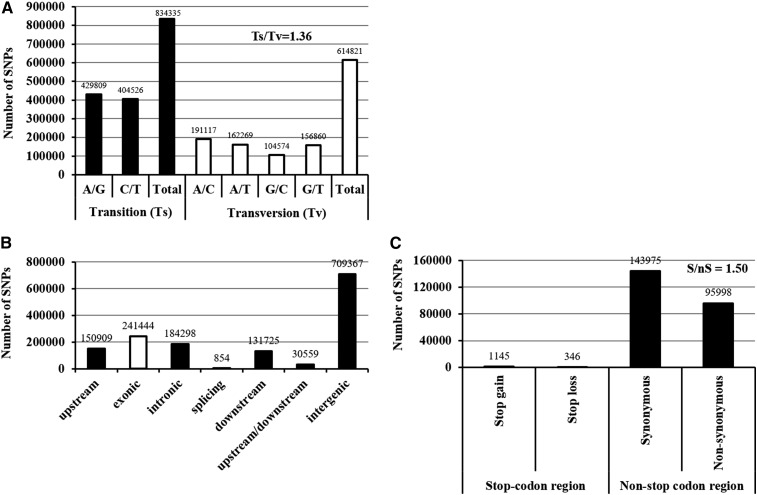
Annotation of single nucleotide polymorphisms (SNPs) identified between the N-efficient genotype “XY15” and the N-inefficient genotype “814”. (A) Transition (Ts) and transversion (Tv) frequency of the SNPs. (B) Genic distribution of the SNPs. (C) Number of the synonymous (S) and non-synonymous (nS) SNPs. The upstream and downstream regions are defined as the 2.0-kb upstream intervals of the start codon (ATG) and the 1.0-kb downstream of the stop codons. The upstream/ downstream regions refer to the overlapped genomic intervals of the upstream and downstream areas between two neighboring genes.